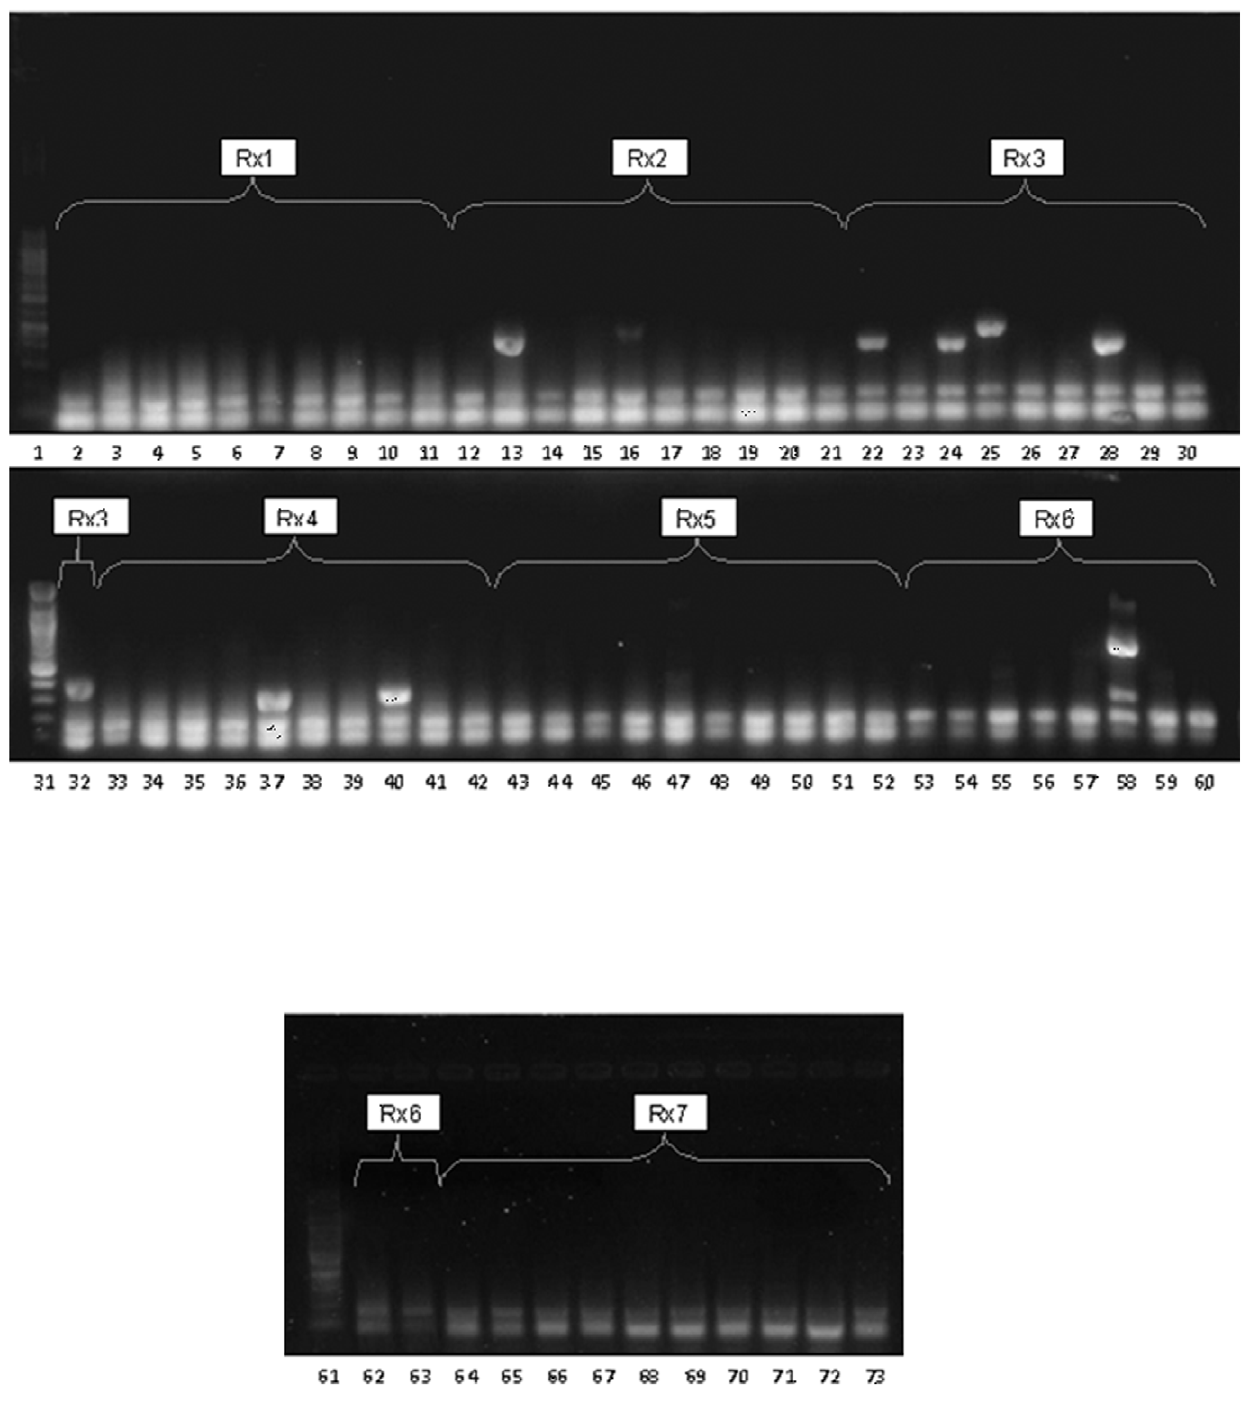
Figure 2. Representative complete seven multiplex reactions performed on 10 R p strains for serotyping. In each reaction, the strains were arranged in the same position accordingly from left to right. The serotypes detected were: PR40(1), PR41(12F), PR44(19F), PR46(11A/D), PR47(12F), PR48(1), PR49(23F), PR50(19F), PR55(not-detected), and PR56(23F) (annotations in parenthesis denotes the serotype; ND: not-detected). Lane 1, 31, 61: 100 kb DNA